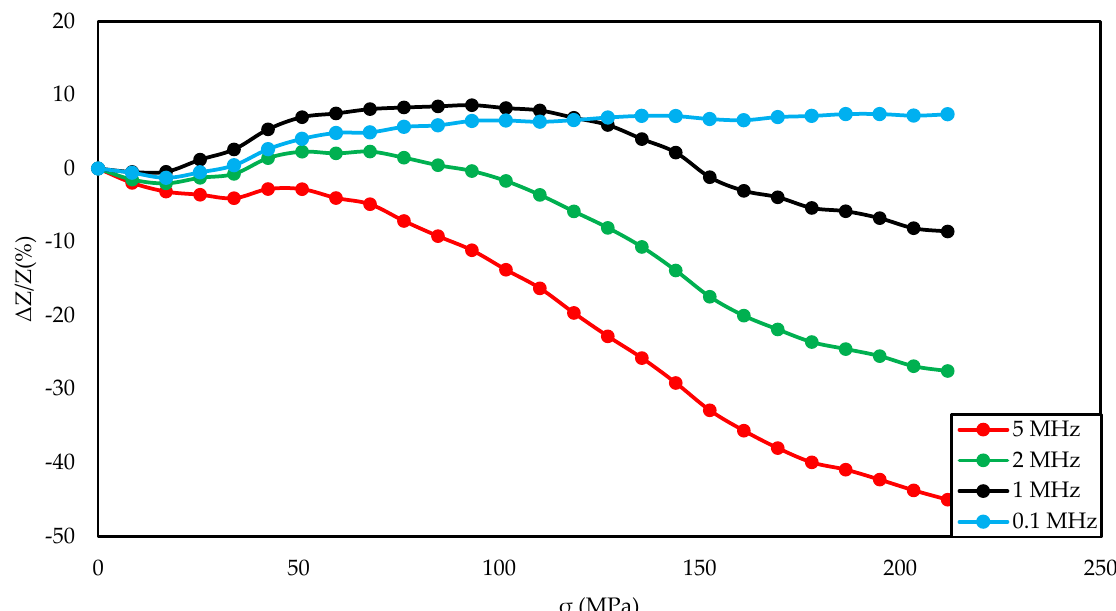
Figure 3. Dependence of impedance in a function of stresses for different magnetizing fields for the as-cast sample.